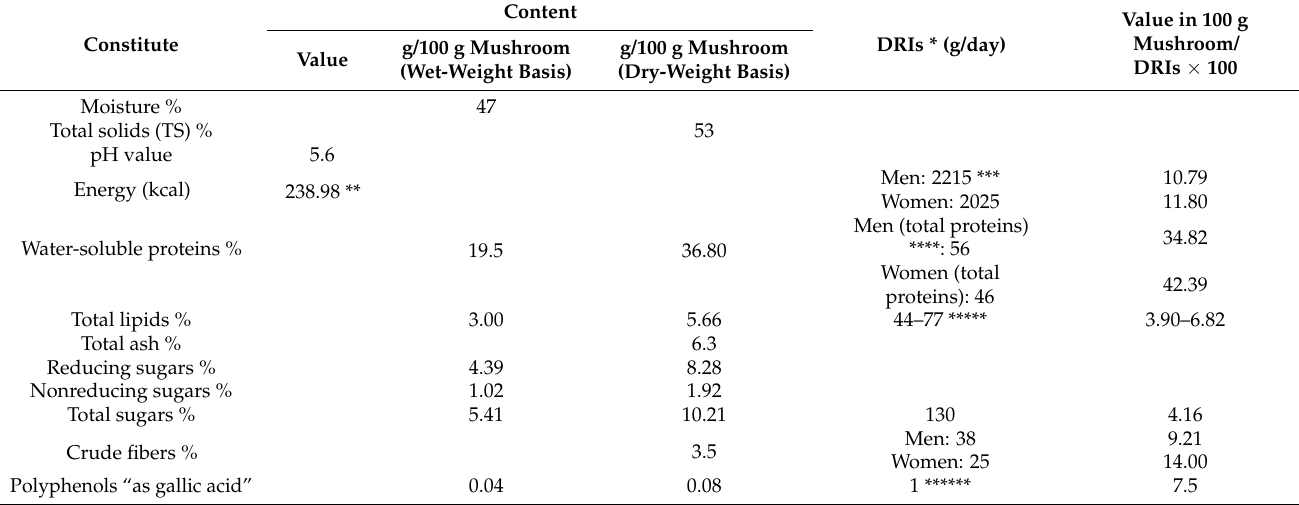
Table 2. Physicochemical properties and chemical composition of Ganoderma lucidum